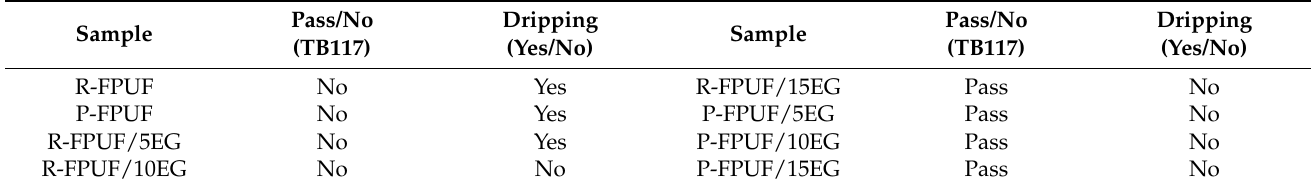
Figure 4. Digital photos of R-FPUF ( a–1 ~ a–3 ), R-FPUF/5EG ( b–1 ~ b–3 ), R-FPUF/10EG ( c–1 ~ c–3 ), R- FPUF/15EG ( d–1 ~ d–3 ), P-FPUF ( e–1 ~ e–3 ), P-FPUF/5EG ( f–1 ~ f–3 ), P-FPUF/10EG ( g–1 ~ g–3 ), P- FPUF/15EG ( h–1 ~ h–3 )at different ignition time.